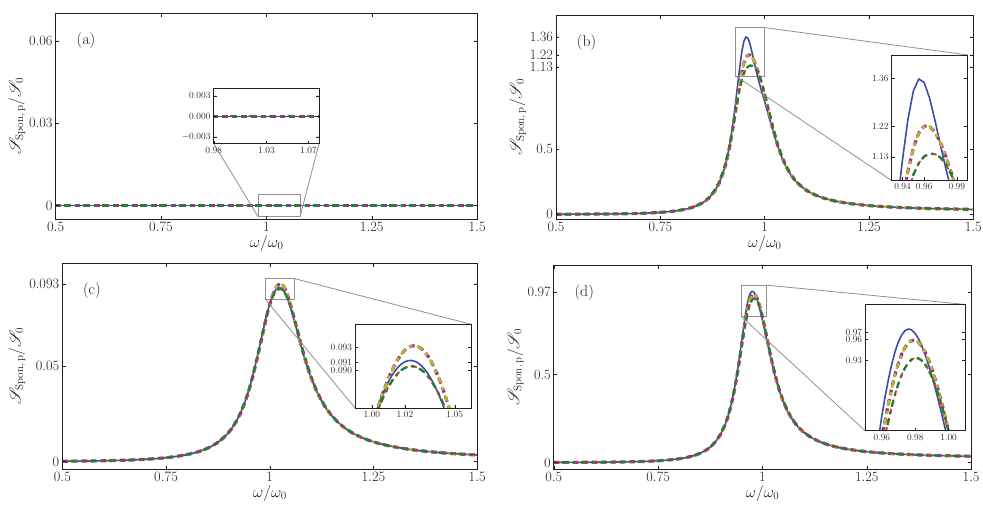
Figure 5. The spontaneous-emission power spectrum of the noise photons (A20), in units of S 0 = ¯ h ω 3 /4 πε 0 c 3 , for p -polarized light exiting the MM at 60 degrees away from the normal direction. 0 In all four panels, the QOEM theory and the quantum optical effective-index theory are compared to the exact multilayer calculation. For the exact multilayer calculation (solid blue curves), the loss and gain layers are described by Lorentz models (Equation (40)) with the same parameters as in Figure 2. Left and right panels correspond to loss-loss and gain-gain metamaterials with the geometry of Figure 6. The loss-loss and the gain-gain multilayers are maintained at zero temperature in panels ( a , b ), and at the elevated positive temperature T = 0.6¯ h ω 0 / k B in panel ( c ), and at the elevated = 0.6¯ h ω T negative temperature 0 / k B in ( d ). For the effective-index theories, red dotted and green | | dash-dotted curves present the numerical parameters as obtained from the scattering method (A15a) and the dispersion method (A17), respectively. For QOEM theory, magenta dashed and yellow dash-dotted lines correspond to these same classical effective parameter retrieval methods (A15a) and (A17). These effective parameters so obtained are also used to compute N eff